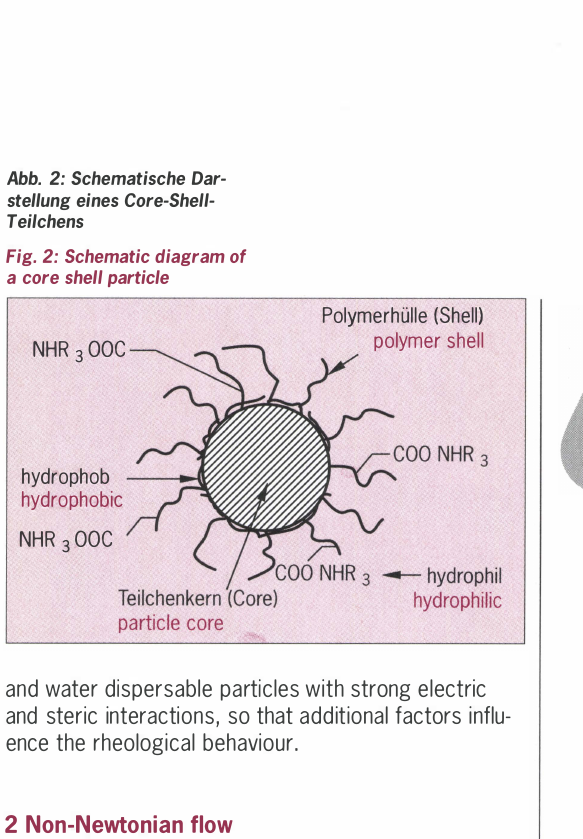
Polymerhulle (Shell) polymer